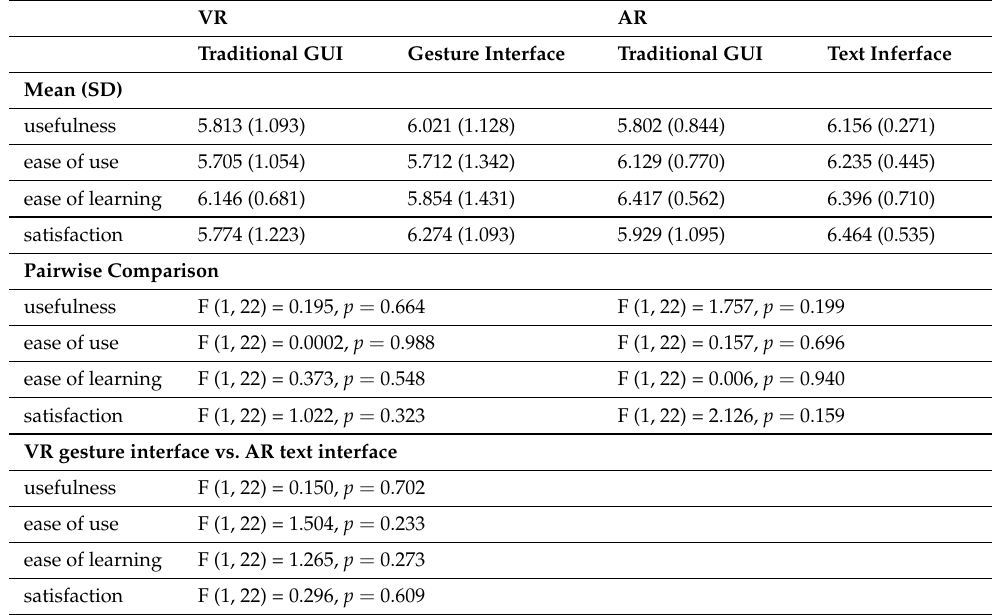
Table 1. Comparative analysis result for satisfaction between the proposed interface using deep learning and the traditional GUI